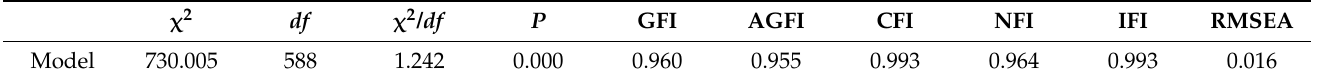
Table 3. Questionnaire model fitting indicators.